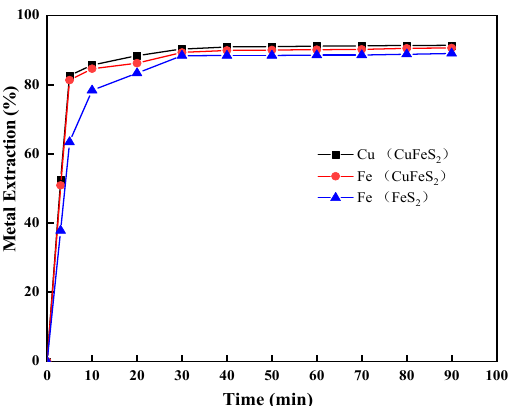
Figure 4. The comparison of leaching efficiency for chalcopyrite and pyrite using TCCA reagent under the same reaction conditions.